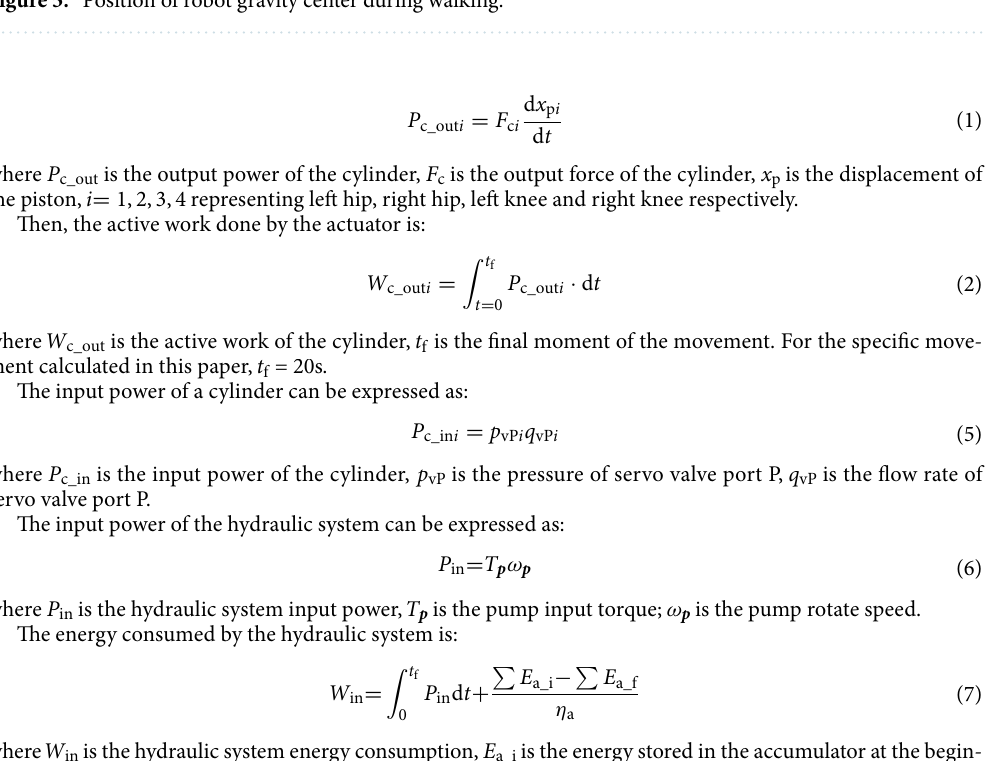
Figure 5. Position of robot gravity center during